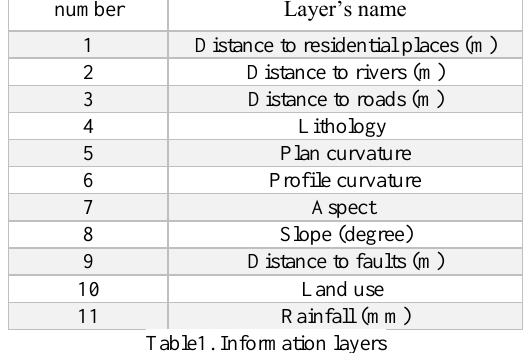
Figure 4. Effective information layers. . a Aspect, b Slope c Plan curvature, d profile curvature, e Faults and distance from faults, f Rivers and distance from rivers, g Residential regions and distance from residential regions, h Lithology